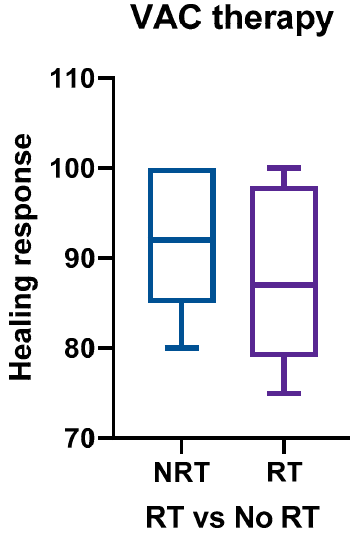
Figure 2. The mean healing response using NPWT therapy in the absence of previous irradiation was found to be 92.40 ± 8.29, compared to 86.7 ± 11.7 with previous irradiation. Abbreviation: RT: radiotherapy; NRT: no radiotherapy; NPWT: negative pressure wound therapy. Table 1. Demographics of the cohort, wound response, healing time, pressure dynamics, comorbidities, risk factors, and complications.